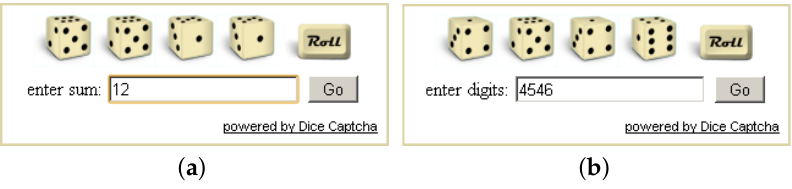
Figure 1. The two types of Dice CAPTCHA: ( a ) Dice 1; and ( b ) Dice